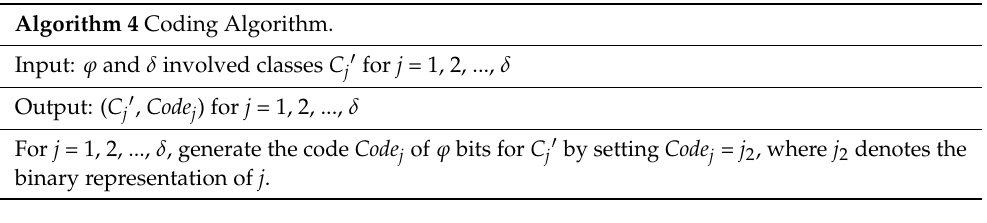
Algorithm 5 Image Encryption